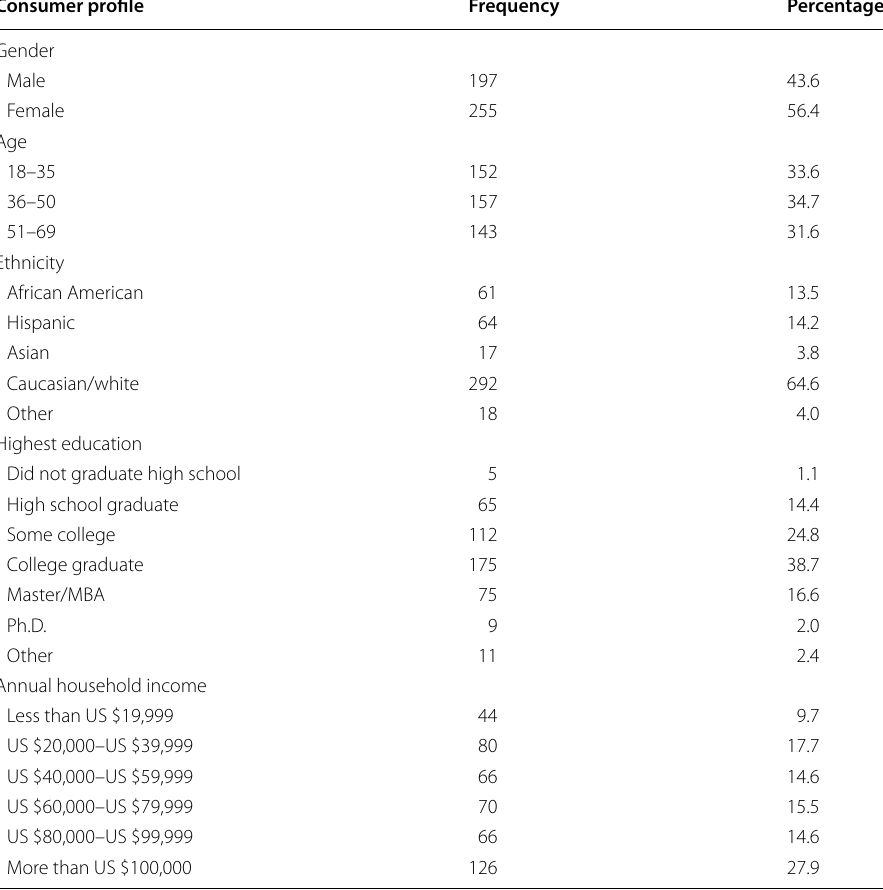
Table 1 Demographic summary of participants (n